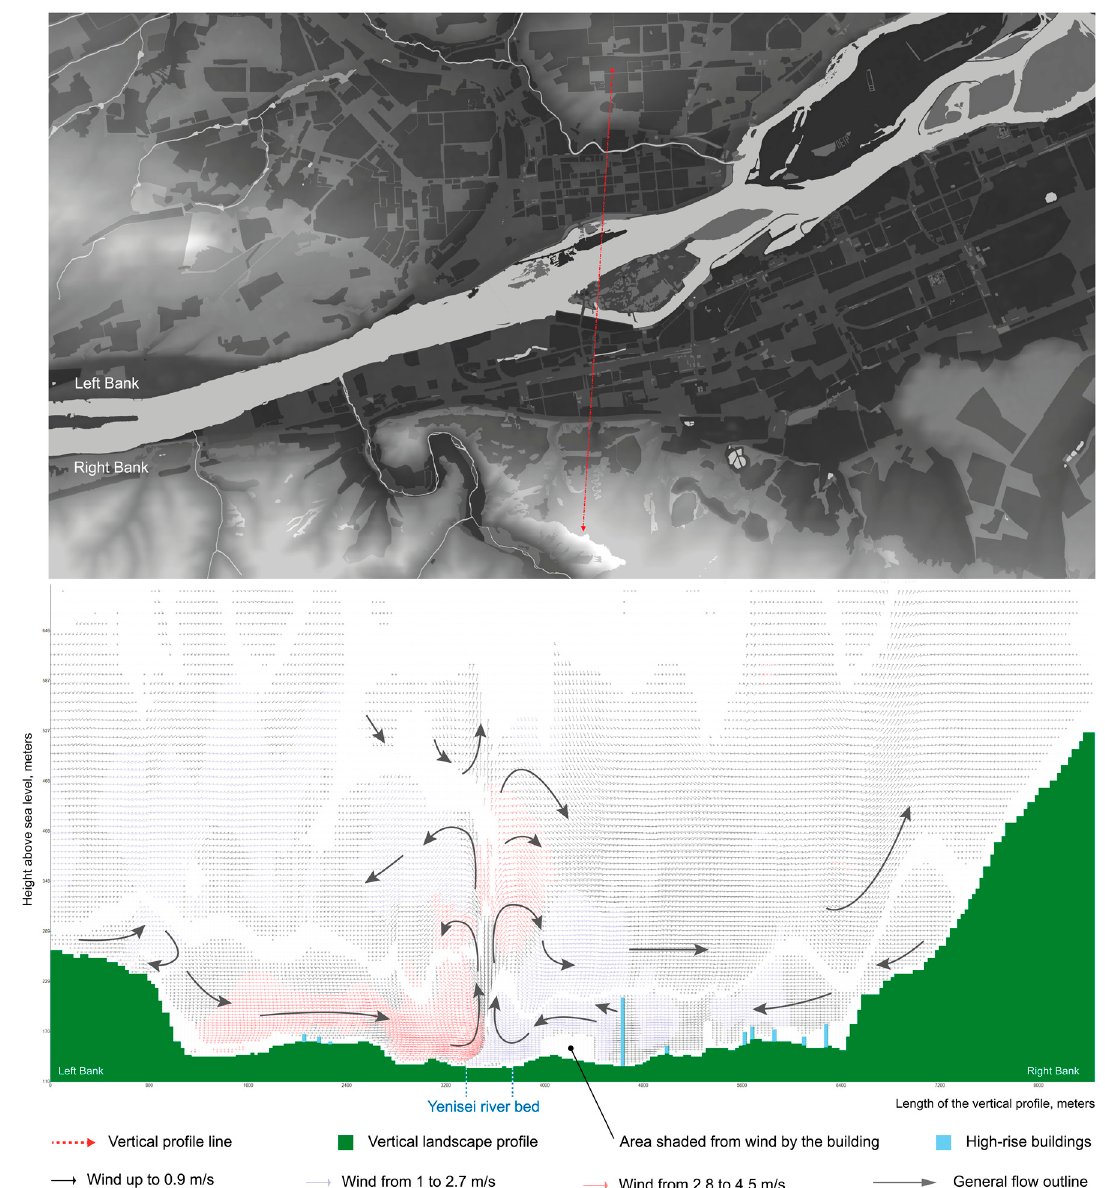
Figure 8. The Krasnoyarsk city atmosphere vertical profile is characterizing the Yenisei river beds influence on a calm air temperature of minus 25 degrees Celsius and water temperature plus 4 degrees Celsius.